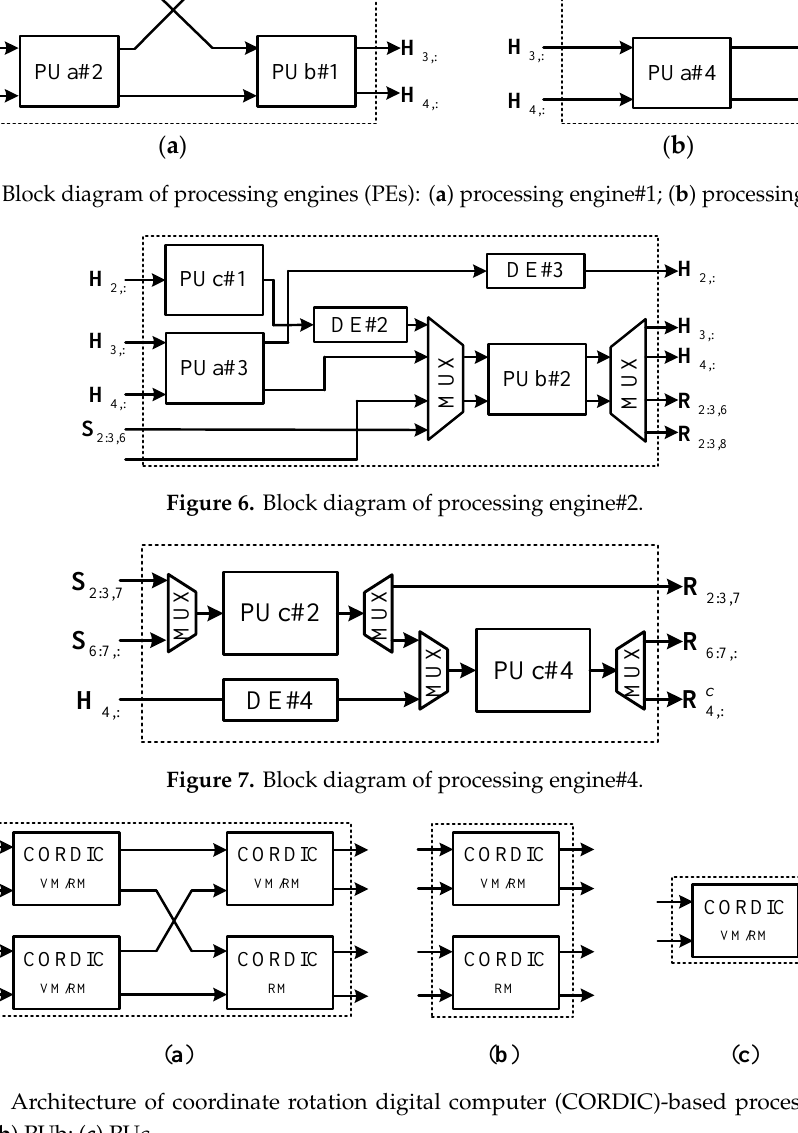
Figure 8. Architecture of coordinate rotation digital computer (CORDIC)-based processing units: ( a ) PUa; ( b ) PUb; ( c ) PUc.